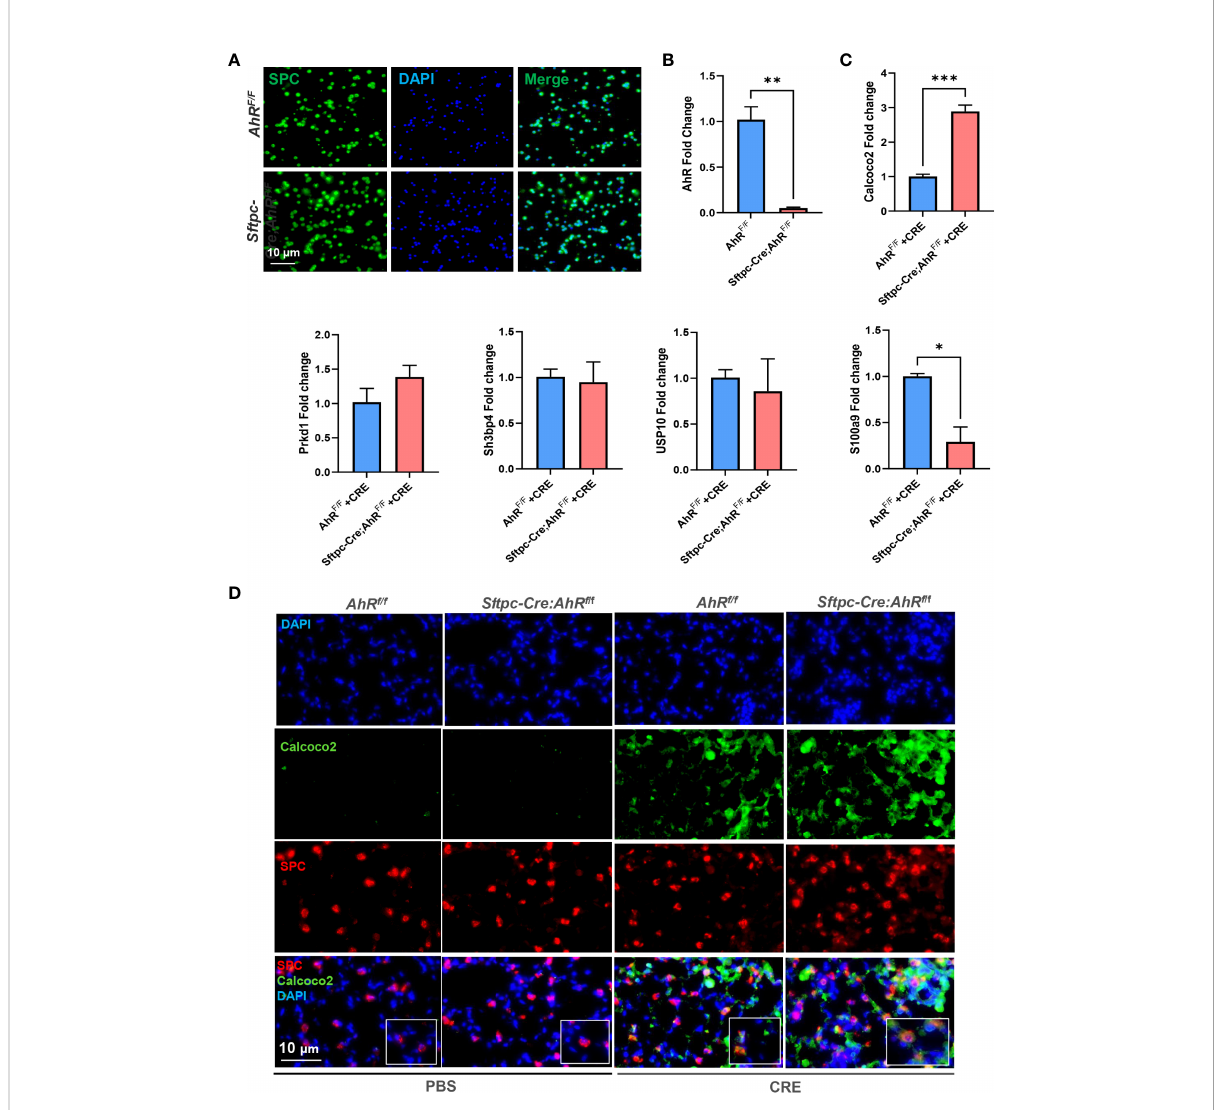
FIGURE 8 Calcoco2 and S100a9 are the major AhR-regulated autophagy-associated genes in AT2 cells. (A) Con fi rmation of AT2 cells isolated from AhR f/f or Sftpc-Cre;AhR f/f mice by immunostaining. (B) Con fi rmation of AhR de fi ciency in AT2 cells derived from Sftpc-Cre;AhR f/f mice by RT-PCR. (C) RT-PCR analysis of highly selected differentially expressed autophagy-associated genes of in AT2 cells. (D) Representative images of co- immuno fl uorescence staining of Calcoco2 with AT2 marker SPC. Data represent means ± SEM of at least two independent experiments. * p < 0.05, ** p < 0.01, and *** p <